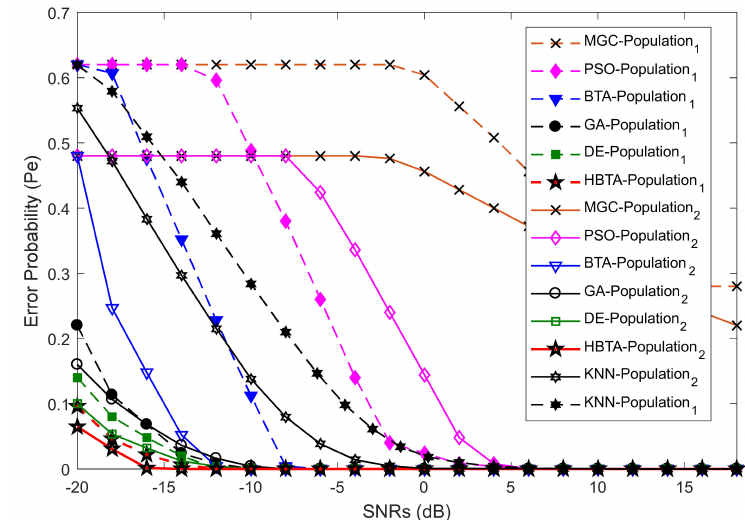
Figure 16. Error probability vs. SNRs in the presence of AY-AYC users with population 1 (30) and population 2 (55).